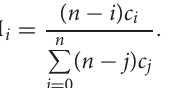
FIGURE 5 | Schematic for clique